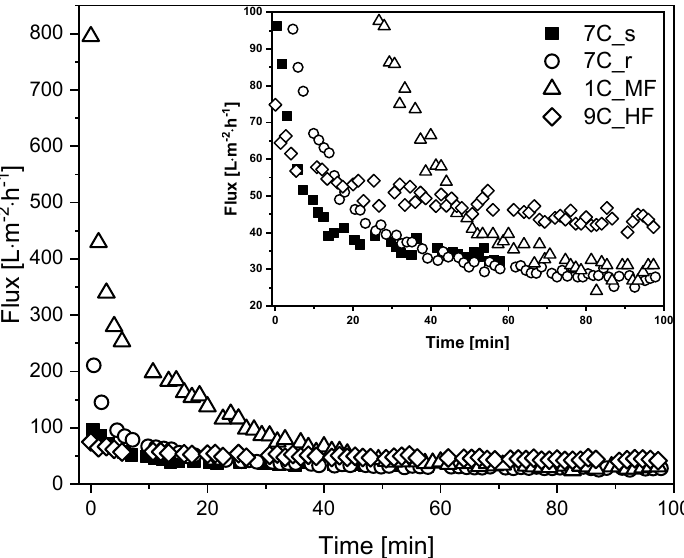
Figure 5. Flux curves during the filtration of fermentation broth with different membranes (TMP = 0.5 bar, temperature = 25 °C). The CFV was 0.8 m s − 1 for all membranes except 9C_HF (CFV = 1.6 m s − 1 ). An enlargement of the graph covering the low-flux region is shown in the upper right corner for clarity. The MF membrane 1C_MF showed the highest J 0 (795 L m − 2 h − 1 ), followed by 7C_r (211 L m − 2 h − 1 ), 7C_s (96 L m − 2 h − 1 ), and 9C_HF (75 L m − 2 h − 1 ). Flux reduction was least severe for the hollow-fiber membrane (~40% loss, falling to 43 L m − 2 h − 1 ) whereas the other membranes lost more than 50% flux within the first 20 min. The tubular membranes reached a comparable J ss of 27–33 L m − 2 h − 1 regardless of the pore size. Given the differences in channel diameter and CFV, the filtrations involving the hollow-fiber membrane (channel diameter = 2 mm, CFV = 1.6 m s − 1 ) and tubular membranes (channel diameter = 6 mm, CFV = 0.8 m s − 1 ) differ in terms of flow regime and wall shear stress. Accordingly, Re = 2731 and τ w = 56.0 Pa for the hollow-fiber membrane in contrast to Re = 4096 and τ w = 12.6 Pa for the tubular membranes. The retention of total protein and biomass was also monitored for the first 60 min of each filtration. We observed no differences in total protein concentration between the feed at the beginning of filtration, the retentate and permeate. The biomass concentration in the retentate varied between 90% and 100% during filtration, and no biomass was detected in the permeate samples. The deposition of biomass on the membrane or in the dead spaces of the filtration apparatus was therefore negligible. The Bradford assay results and biomass monitoring data are provided in Supplementary Material S1.2. 3.5. Calculated Resistances for the Filtration of Fermentation Broth Figure 6 shows the membrane resistances for the filtration runs discussed above and partitions them into reversible and irreversible resistances. The intrinsic membrane resistance R m was calculated from the values shown in Figure 3 (TMP = 0.5 bar). Given the differences in R m despite similar overall resistance R ferm, tot , there are nevertheless also clear differences in R ferm when comparing the tubular membranes. The absolute values of